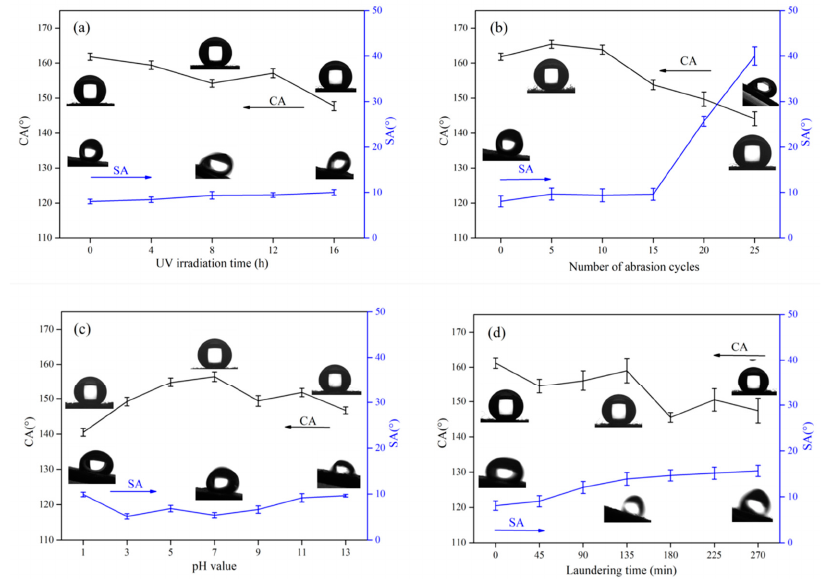
Figure 7. Changes in the CAs and SAs of the superhydrophobic cotton after ( a ) UV irradiation for di ff erent times, ( b ) the abrasion test at 500 g loading on 1500 CW sandpaper for di ff erent times, ( c ) immersion in di ff erent pH values for 48 h, and ( d ) washing for di ff erent times.